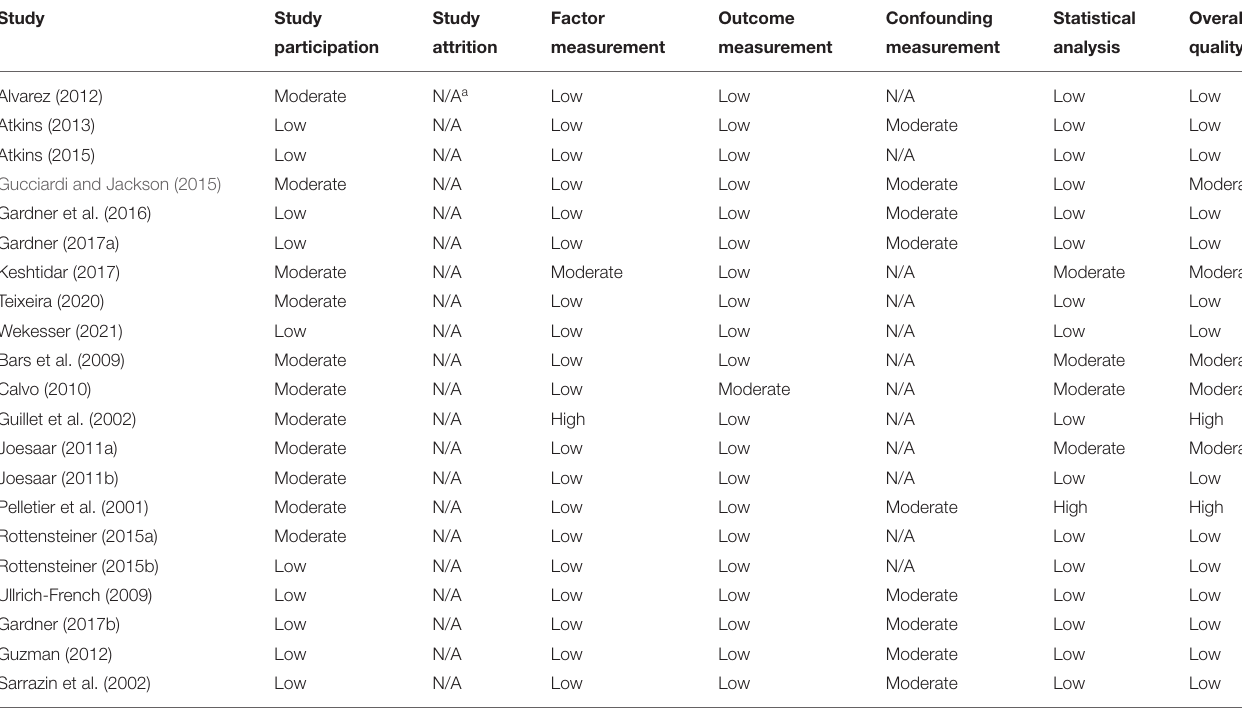
TABLE 4 | QUIPS risk of bias assessment.